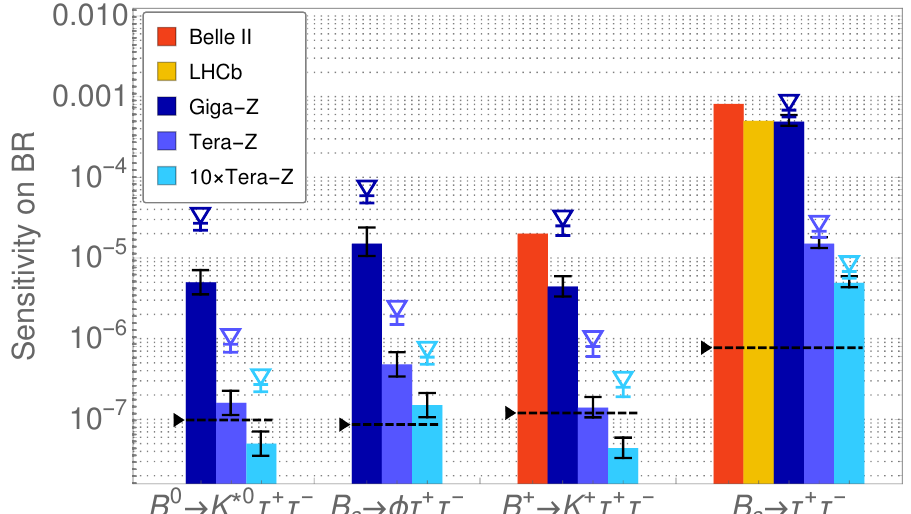
Figure 7 . Expected precisions ( @1 σ C.L.) for the measurements of B 0 → K ∗ 0 τ + τ − , B s → φτ + τ − , B + → K + τ + τ − and B s → τ + τ − at Belle II, LHCb and the future Z factories. Here horizontal black dashed lines stand for the SM predictions. The error bars represent the precisions obtained by varying the experimentally measured backgrounds by one sigma and the semi-quantitatively estimated ones by a factor of two, upward and downward respectively. The double bars below the inverted triangle denote the sensitivities with a finite spatial resolution, i.e., 5 µ m and 10 µ m respectively, for the